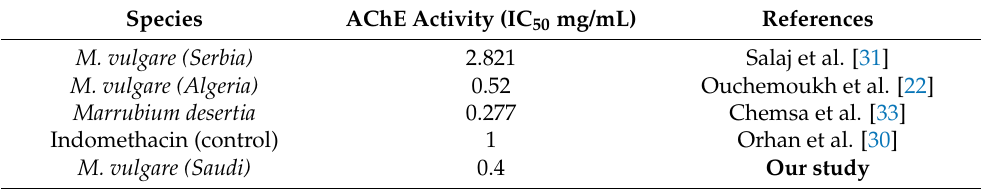
Table 3. Acetylcholinesterase inhibitory activity of the diverse plant extract reported in different studies.